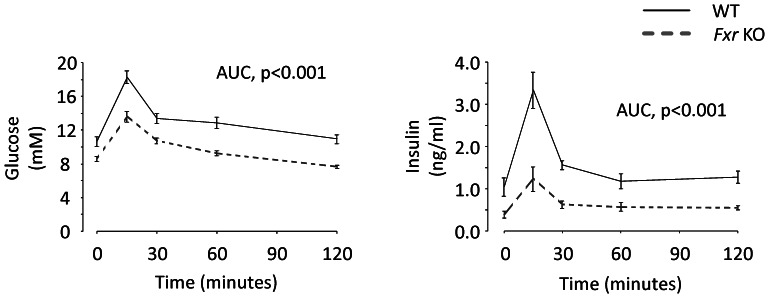
Glucose tolerance.Oral glucose tolerance test in WT (n = 7, black solid line) and Fxr KO mice (n = 7, grey dashed line) mice. Statistical analysis of area under the curve (AUC) values was performed using Student's T-test.